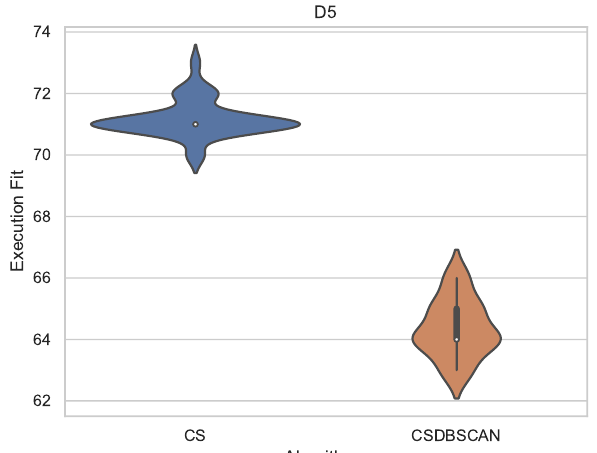
Figure 10. Instance D.5 distribution.